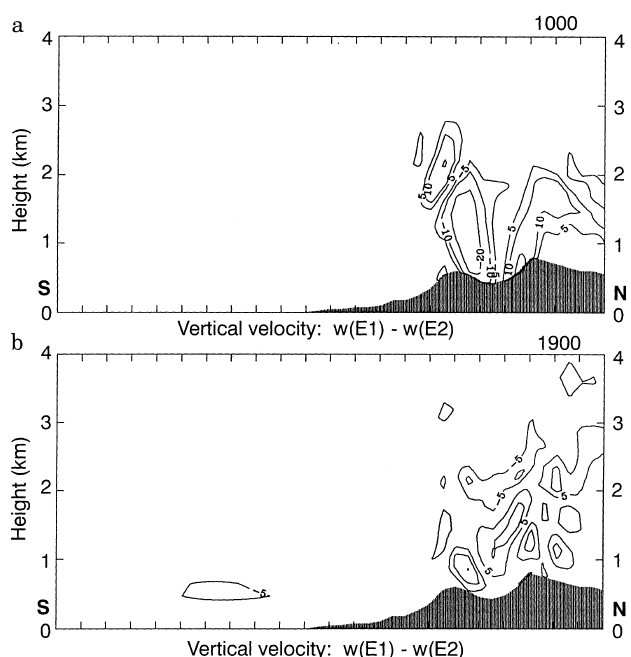
Fig. 5a, b. Vertical cross sections of di(cid:128)erences between vertical wind speed without and with background wind in cm/s at a 1000 LST; b